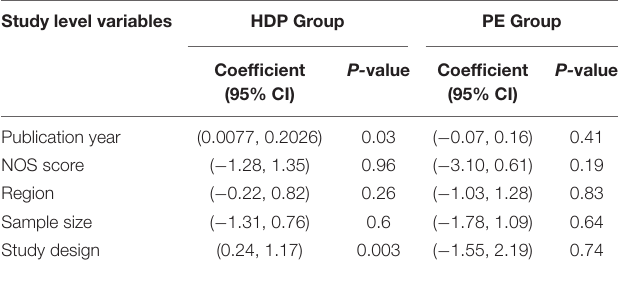
TABLE 3 | Results of the meta-regression